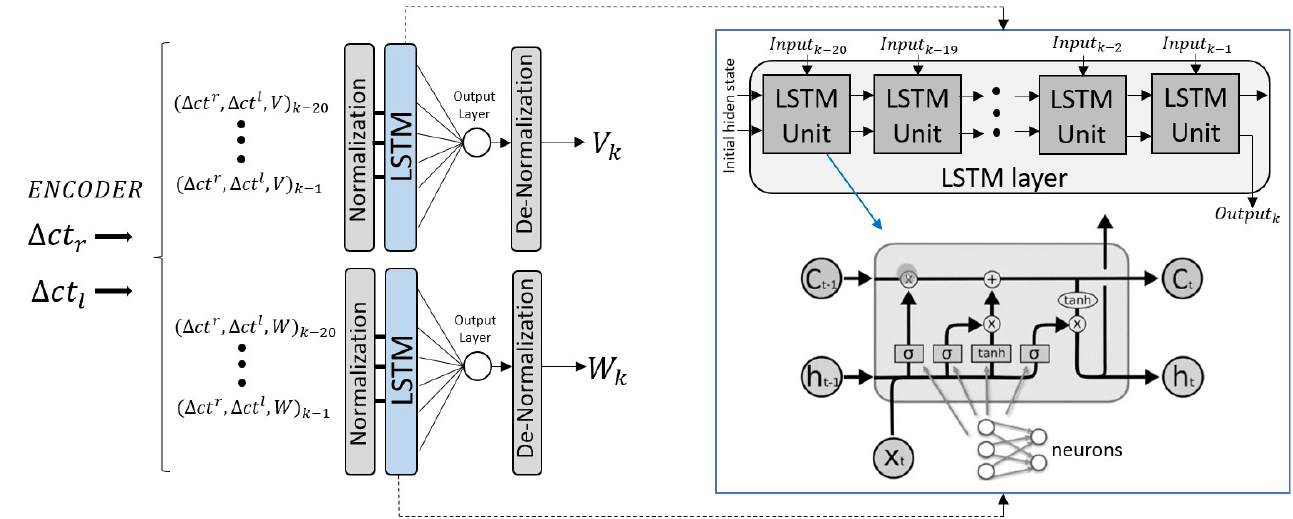
Figure 4. Schema of the odometric model proposed using LSTM